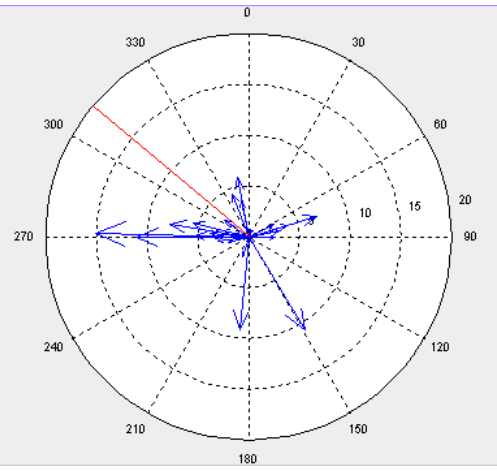
Figure 5. Example of vector diagram plotting of each discrepancy by size (blue) and mean direction (red) (concentric circles are at 5 m